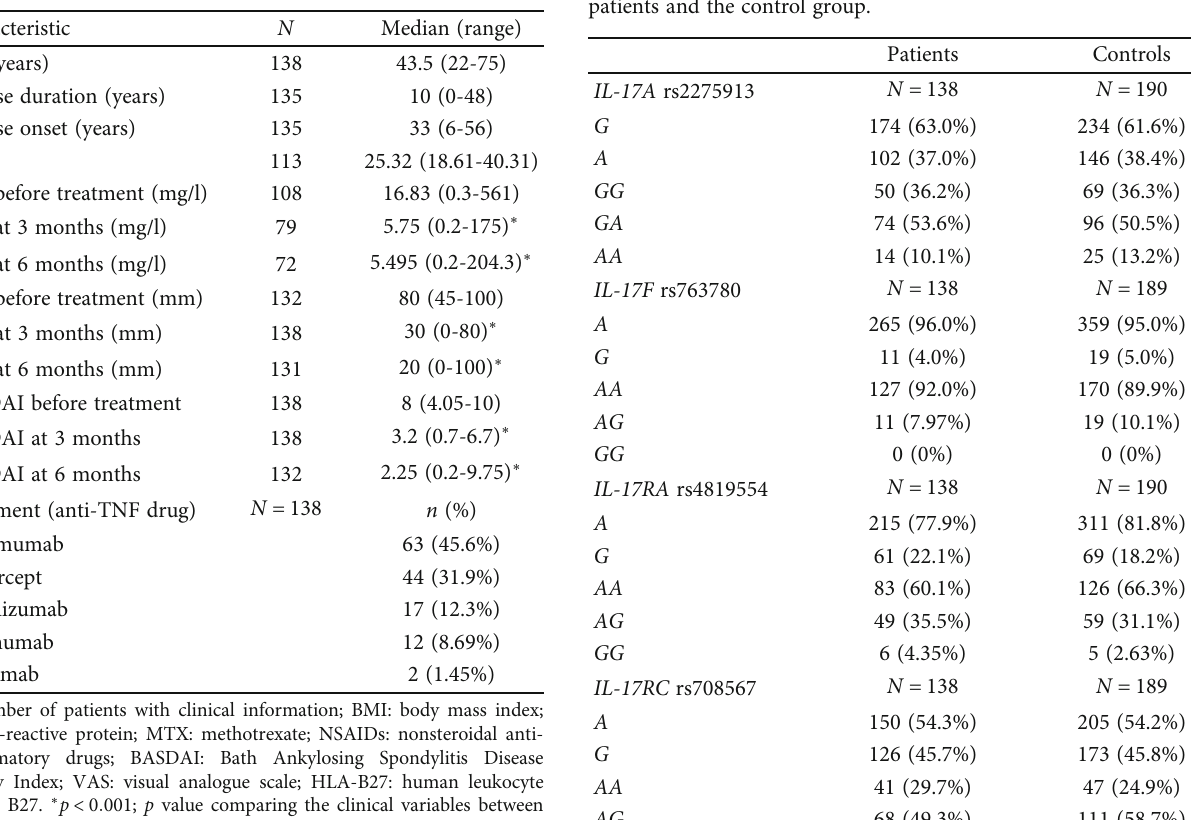
Table 1: Clinical characteristics of the study cohort.